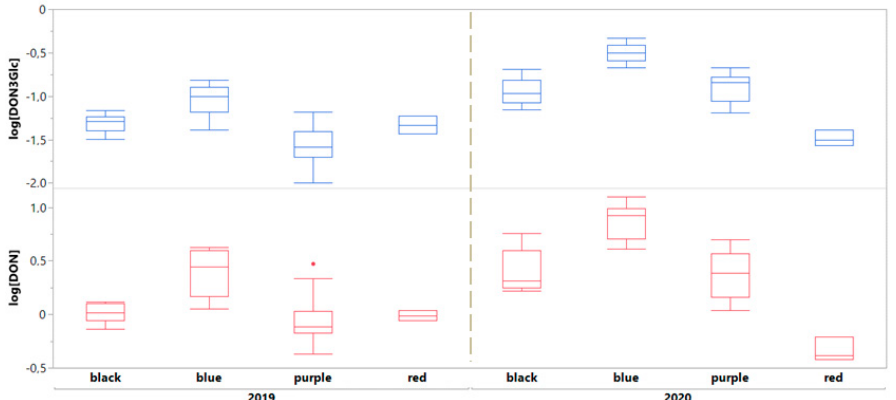
Figure 2. Box plot describing the DON and DON3Glc content in pigmented grains clustered according to the group and the harvest year. Data are log